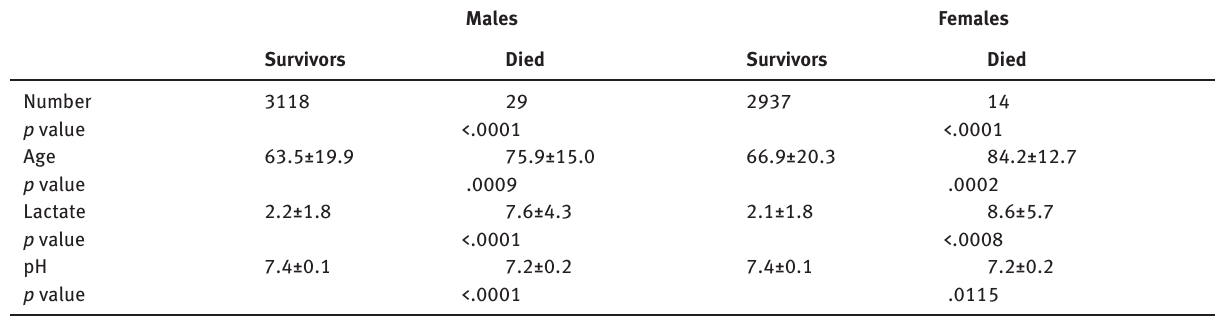
Table 2: Analysis of Difference between Patients by Outcome and